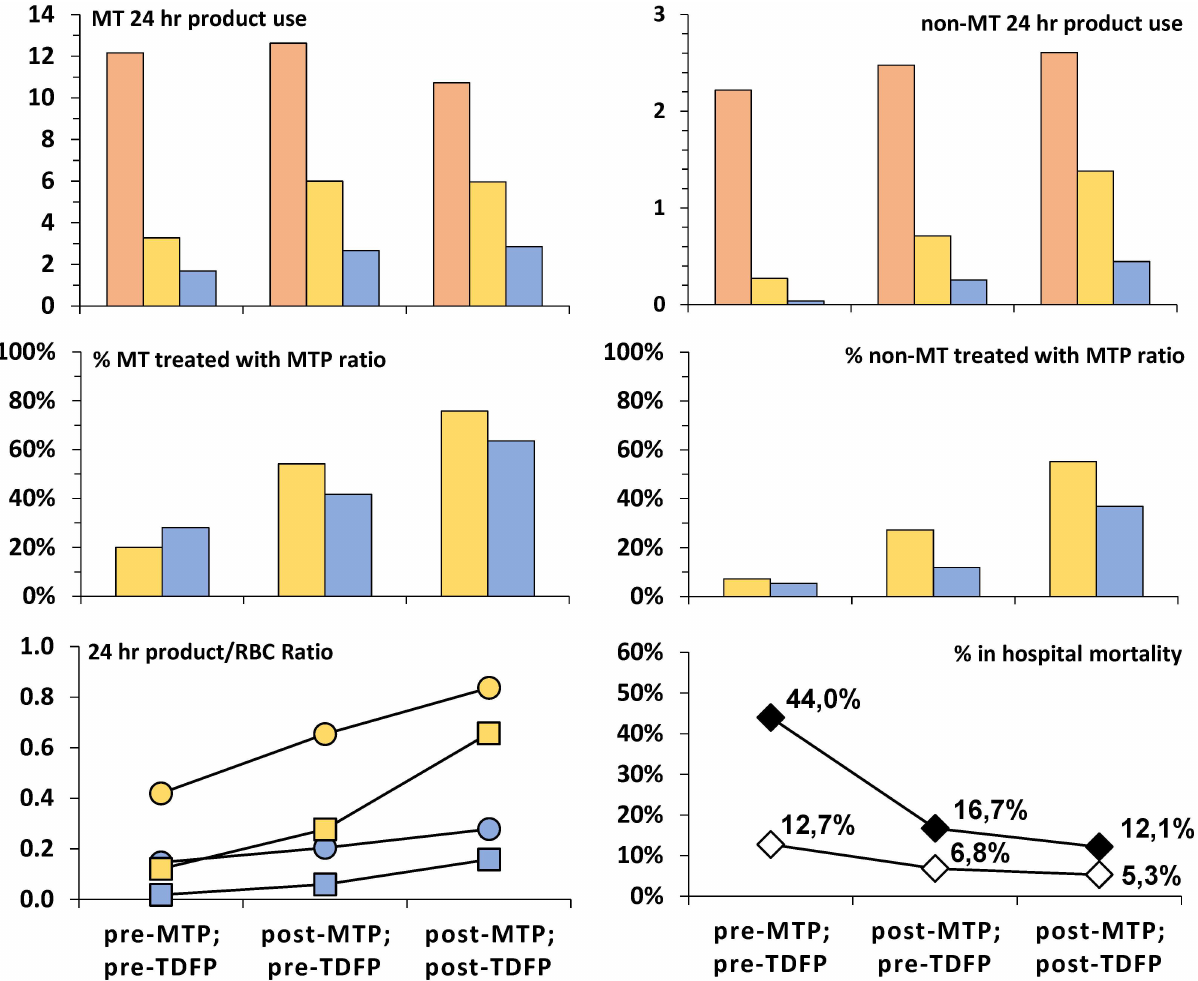
Fig 4. Introduction of TDFP, effect on blood product use and accompanying survival. TDFP indicatesthawed deep frozen plasma, MT : massive transfusion, MTP : Massive Transfusion Protocol, RBC : red blood cell, DTC : deep frozen thrombocyte concentrate, pts : patients. Upper panel: red = RBC; yellow = frozen plasma; blue = frozen platelets. Middle panel: yellow :(plasma+ plasma of DTC):RBC (cid:21) 1:1.5, blue : DTC:RBC (cid:21) 1:5. Lower panel left: yellow :(plasma+ plasma of DTC)/RBC, blue :DTC/RBC, circles : MT pts, squares :non-MT pts. Lower panel right: black diamonds :MT pts, white diamonds : non-MT pts. Time frames duringthe periodstudied: pre-MTP; pre-TDFP: 08/2006–10/2007, N = 25 MT / 55 non-MT post-MTP; pre-TDFP: 11/2007–03/2009,N = 24 MT / 59 non-MT post-MTP; post-TDFP: 04/ 2009–10/2010, N = 33 MT / 76 non-MT.